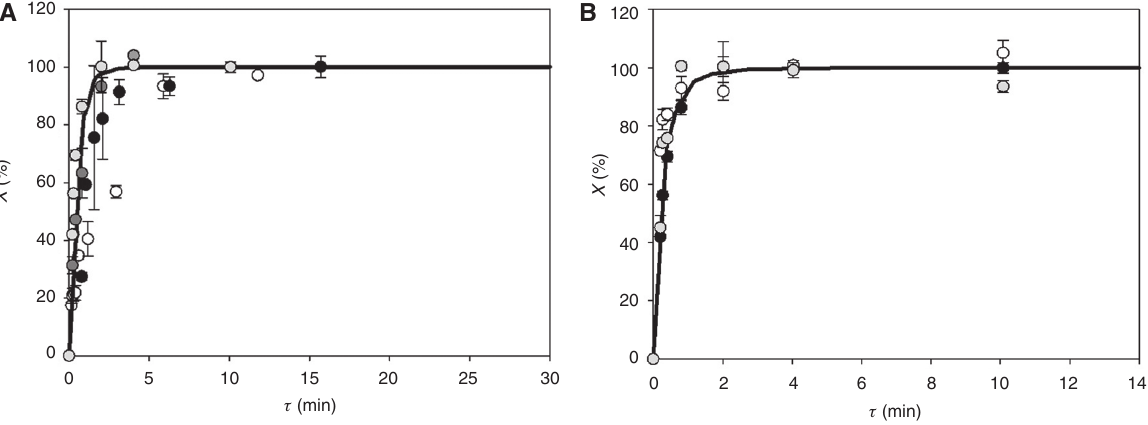
Figure 3 NADH coenzyme regeneration in a PTFE microreactor A) influence of magnetic type (○ square magnet, ● cylindrical magnet, electromagnet with ● stationary particles and ● oscillating particles) and B) influence of nanoparticle concentration (electromagnet with oscillating particles; ○ 5 mg, ● 2.5 mg, ● 0.5 mg, S.A. = 118 ± 6 U/mg, —